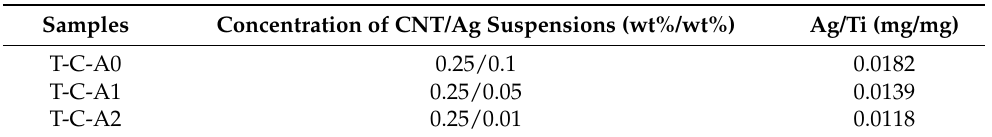
Table 1. Elemental analysis of the T-C-A film using inductivity coupled plasma optical emission spectrometry.